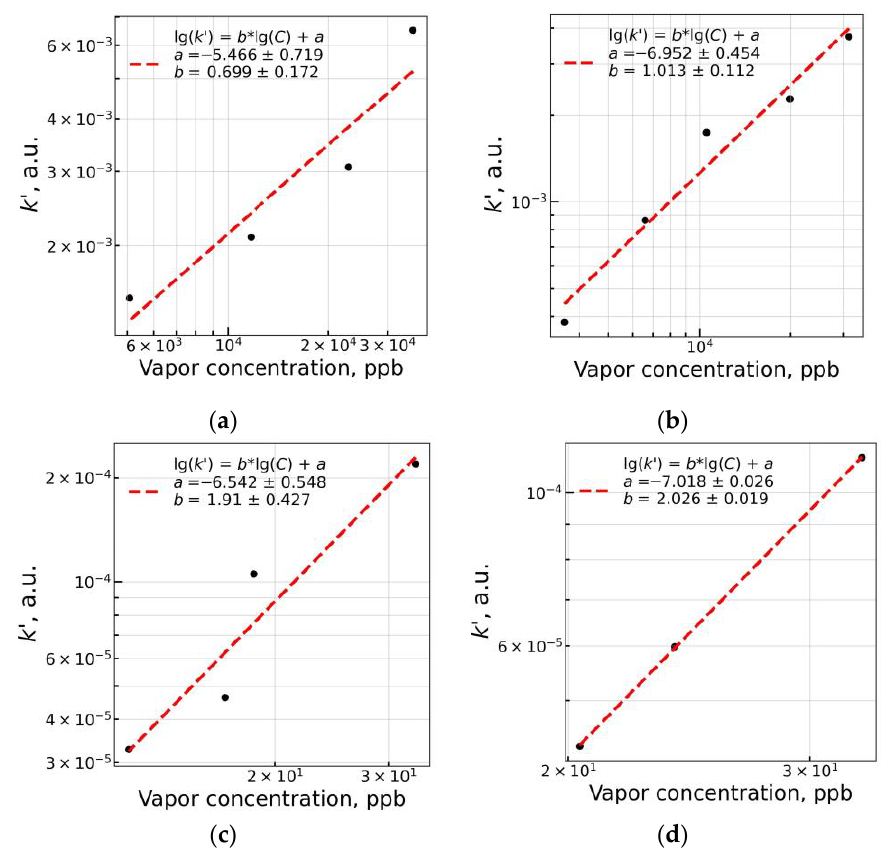
Figure 15. lg( k ’) vs. lg( C ) plots for materials mF/Elsp ( a , c ), mF+PS ( b , d ) with NB ( a , b ) and 2,4-DNT ( c , d ) as vapor phase quenchers.